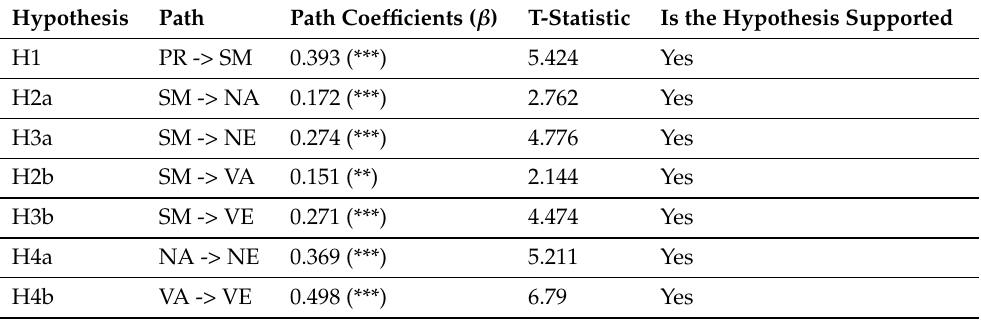
Table 5. Hypothesis testing of Perceived Risk of COVID-19, Surveillance Motivation, and Mediat- ing variables.